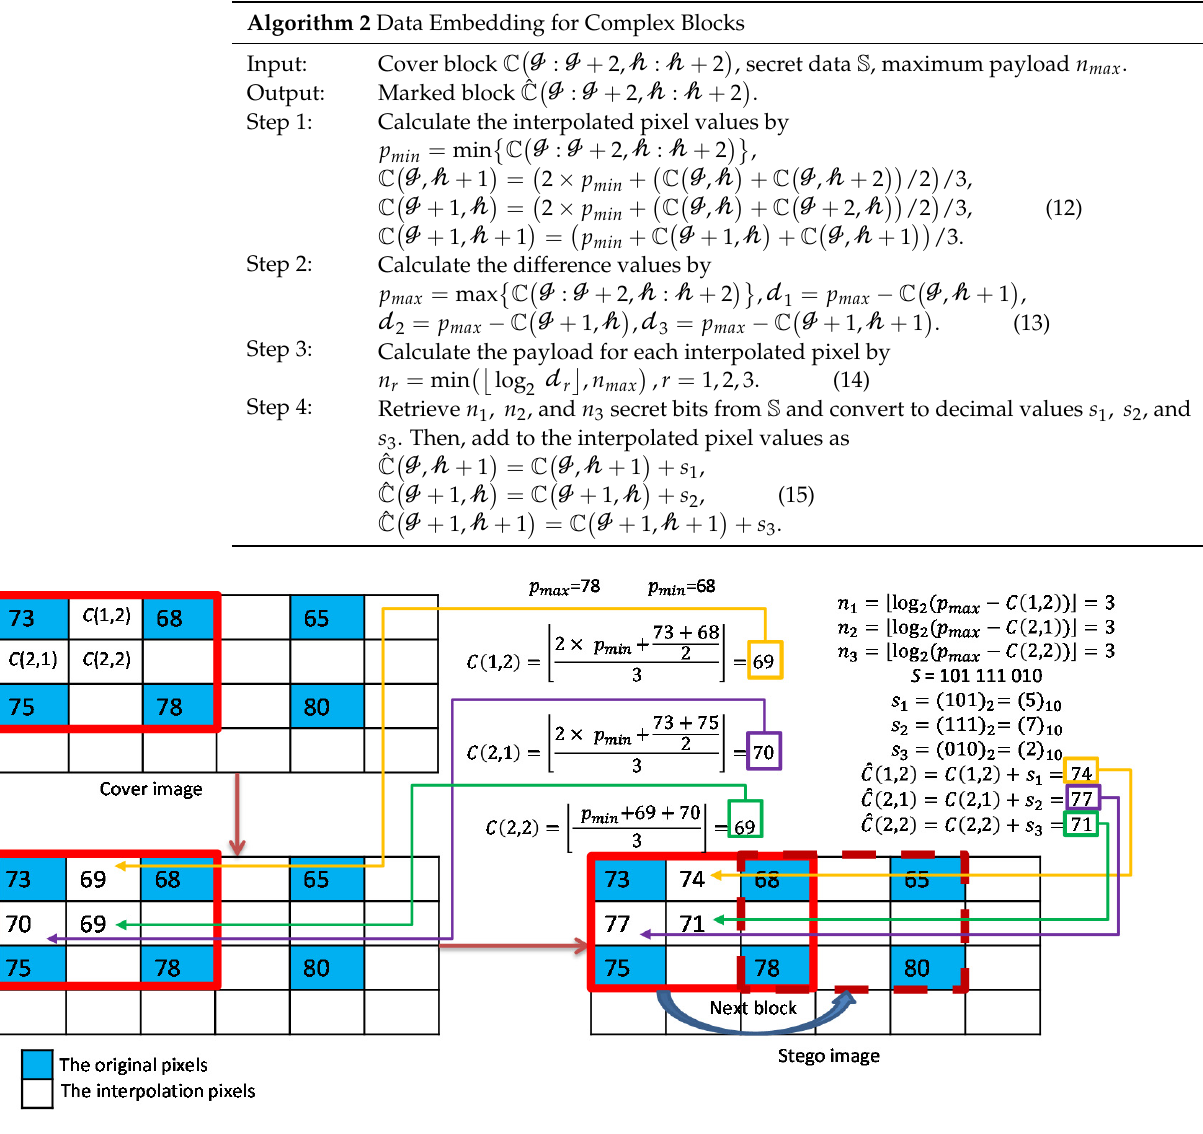
Figure 6. Example of interpolation and data embedding for complex blocks.